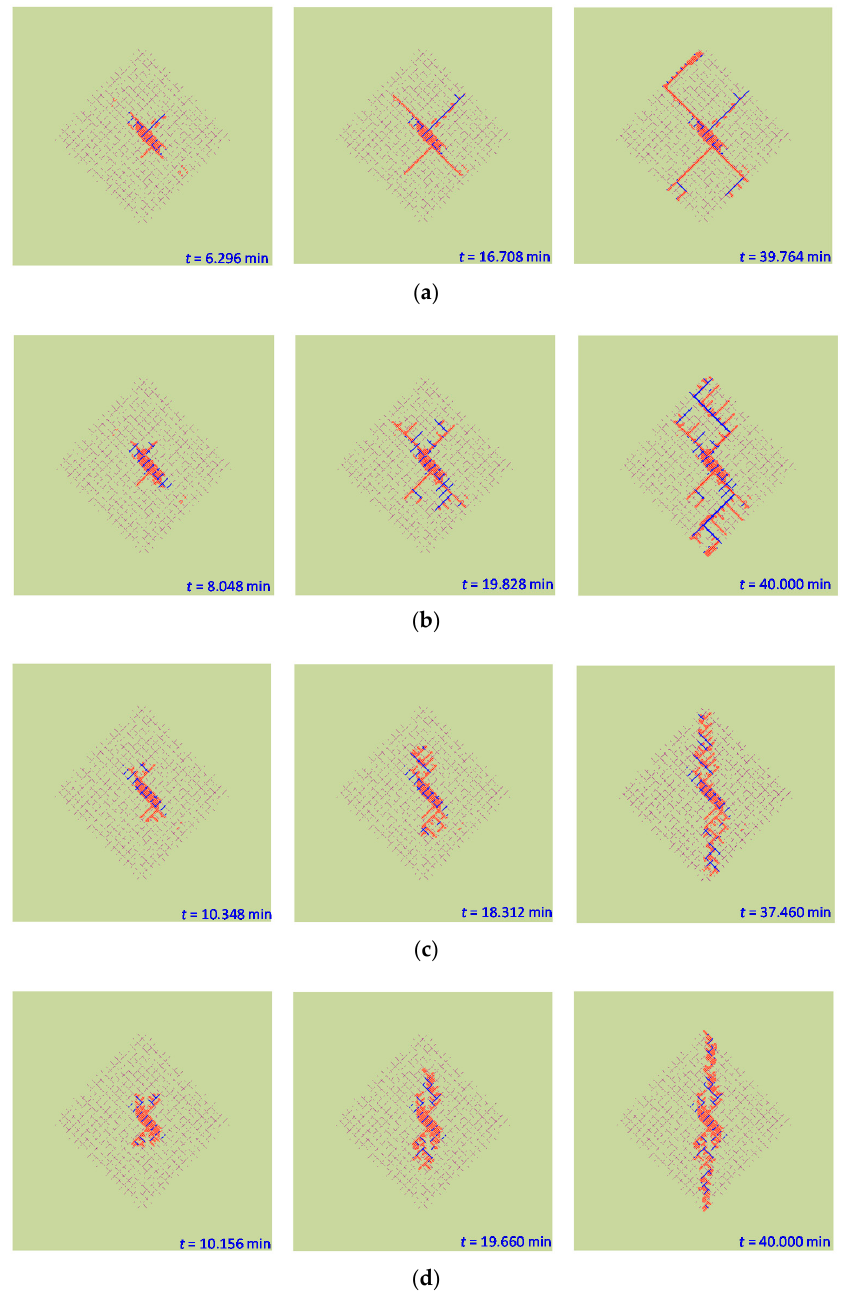
Figure 9. The hydraulic fracture propagation process in a discontinuous natural fracture network under different stress conditions. ( a ) σ 1 − σ 3 = 2.5 MPa; ( b ) σ 1 − σ 3 = 5 MPa; ( c ) σ 1 − σ 3 = 7.5 MPa; ( d ) σ 1 − σ 3 = 10 MPa. The red lines represent the new fractures induced by hydraulic fracturing, the blue lines represent the natural fractures with hydraulic liquid flowing, and the purple lines represent the discontinuous natural fracture network.